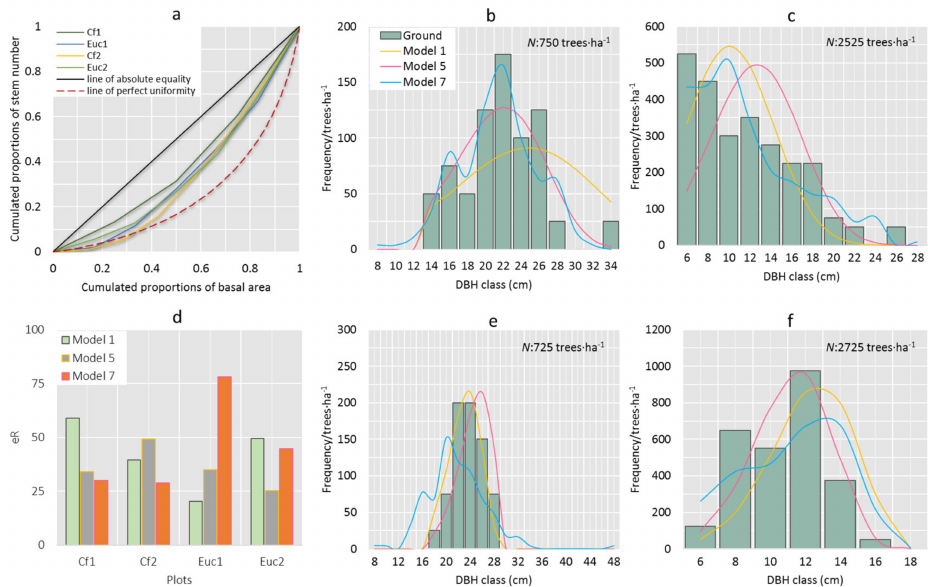
Figure 7. The ground diameter distributions of four differentiated unimodal sample plots with relative low ( b , e ) and high stem density ( c , f ) predicted by Model 1, Model 5 and Model 7. ( a ) The LiDAR-predicted Lorenz curves of four sample plots; ( b , c ) Chinese fir plots; ( e , f ) Eucalypt plots; ( d ) The Reynolds error index of predicted diameter distributions of four sample plots. Notes: Cf1 and Cf2 = Chinese fir plot 1 ( b ) and 2 ( c ); Euc1 and Euc2 = Eucalypt plot 1 ( e ) and 2 ( f ); Model 1 = UWM for undifferentiated all plots; Model 5 = UWM for differentiated unimodal plots; Model 7 = KNN model for all plots.